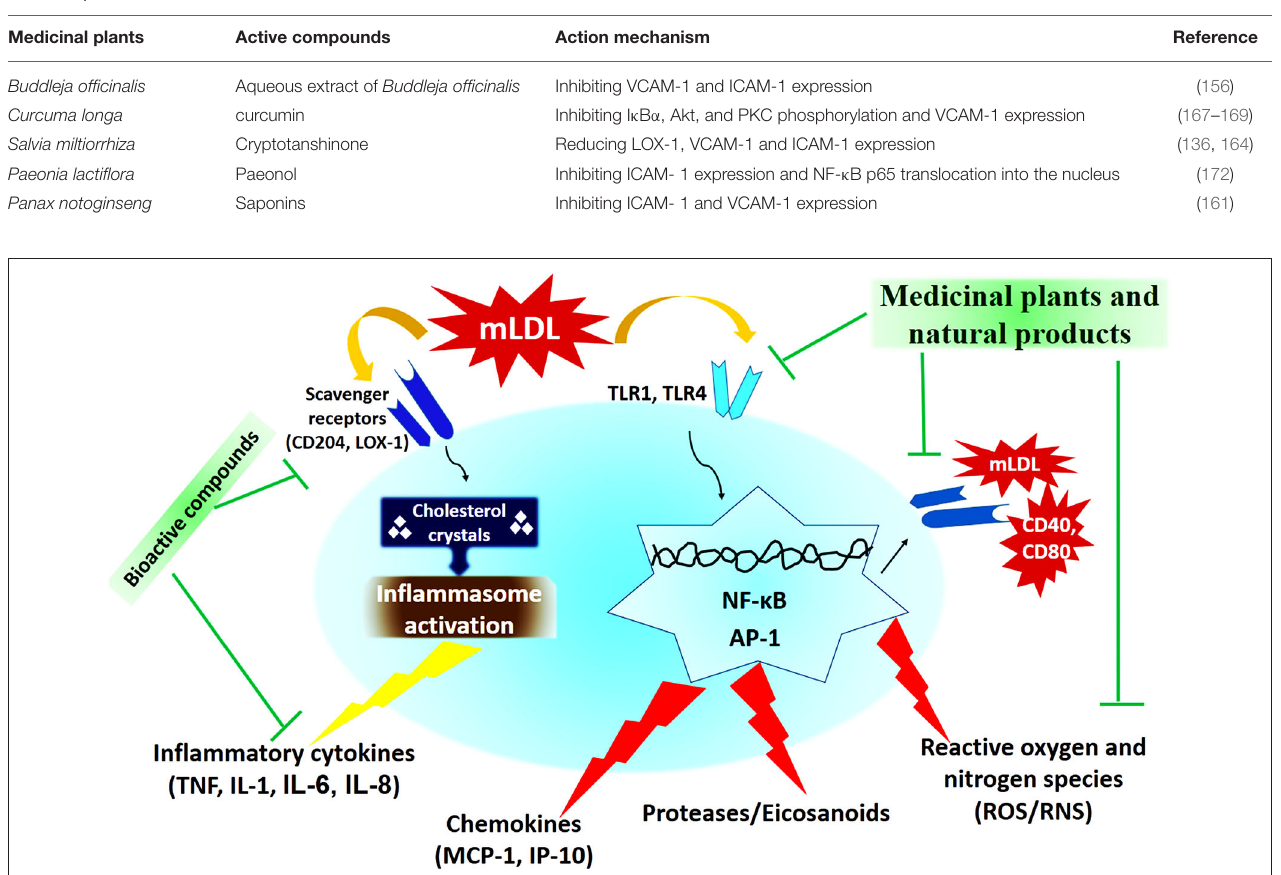
FIGURE 2 | The cellular mechanism of atherosclerosis development and mechanisms of action of medicinal plants and natural products (173).